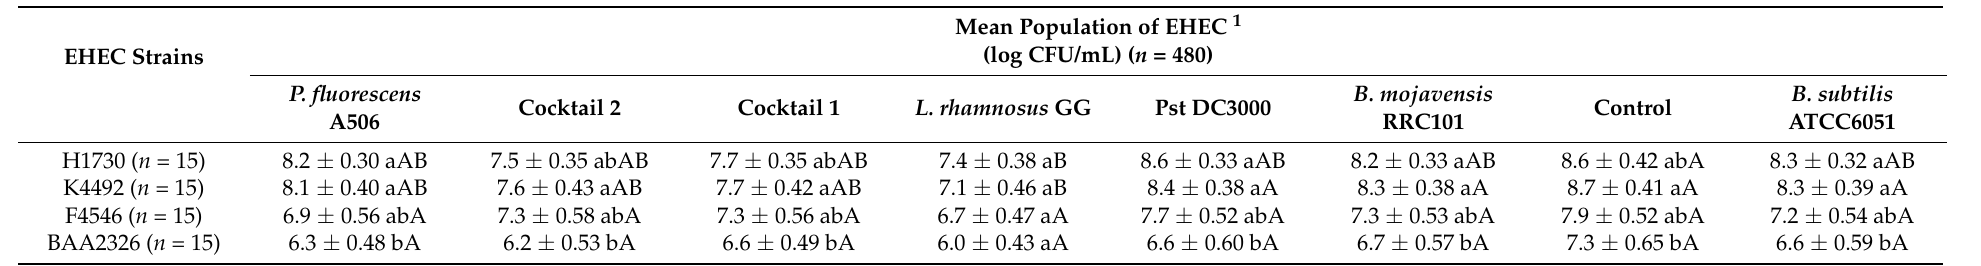
Table 4. Mean populations of individual EHEC strains in co-cultures with different competitive bacterial strains and the plant pathogen at 25 ◦